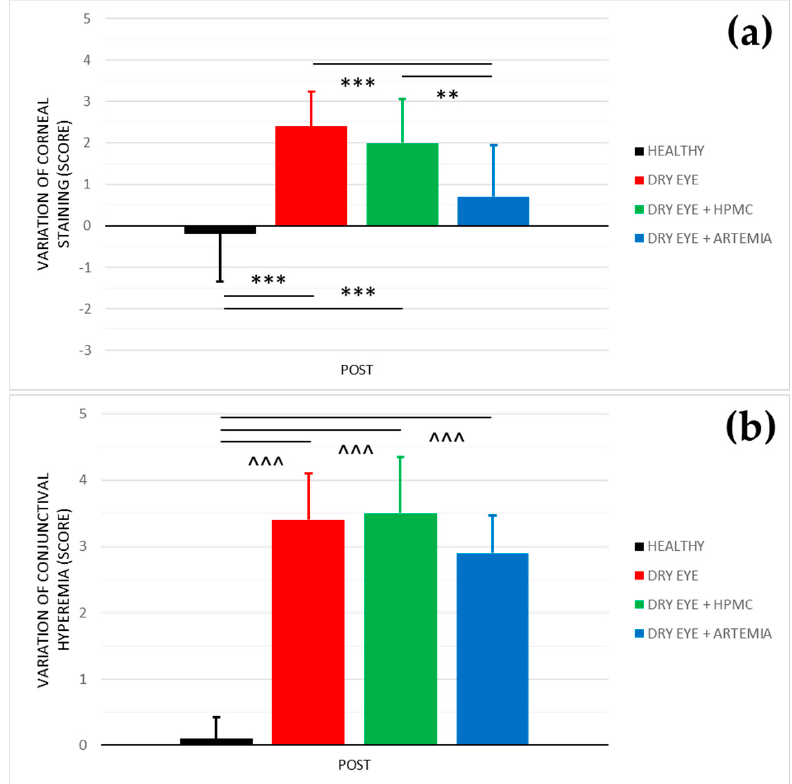
Figure 2. Variation of corneal staining ( a ) and conjunctival hyperemia ( b ) after the instillation of the different treatments for 5 consecutive days. The values higher or lower than 0 represent a deterioration or an improvement in comparison with their baseline, respectively. The statistical comparison was performed between the different groups ( n = 5, each group). ** p < 0.01, *** p < 0.001, Student’s t -test for independent samples (normal distributions). ^^^ p < 0.001, Mann–Whitney U test (non-normal distributions).